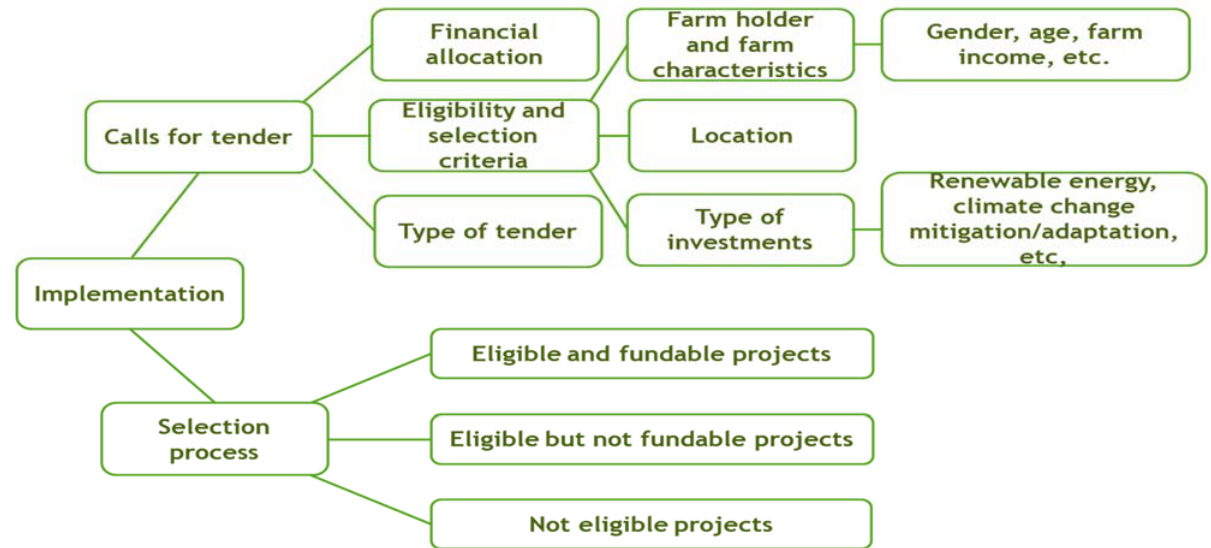
Figure 3. RDP implementation level (call for tenders and selection process): more specific definition of territorial priorities.